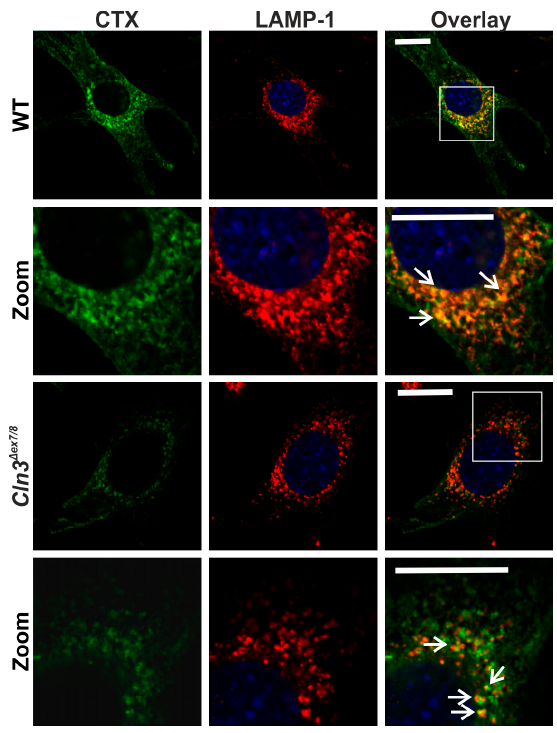
Figure 5. GM1a partially colocalizes with lysosomes in both WT and Cln3 ∆ ex7/8 cells. The cells were stained with CTX-A488 (green) and anti-LAMP1 antibody (red) and imaged using a confocal microscope. Second and bottom row show an enlargement of the perinuclear area, depicted by a white frame in the overlay images on the first and third rows, respectively. Arrows point to examples of colocalization. The green signal in the overlay image of the Cln3 ∆ ex7/8 cells was enhanced using the “best fit” function of the Zeiss Zen software to better depict the colocalization. Scale bar: 20 µ m. Images show representative data from 3 independent